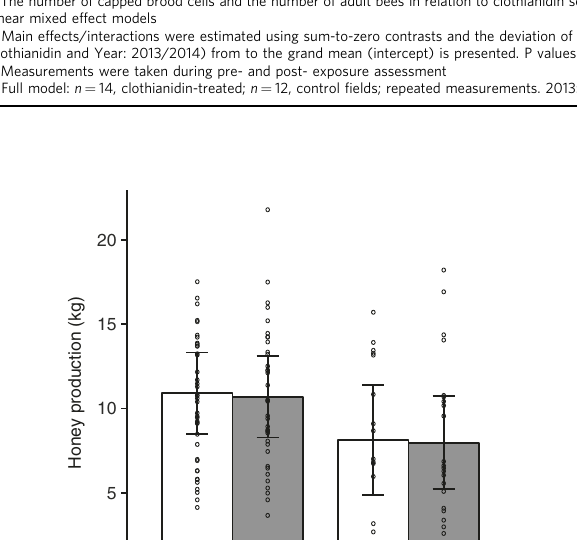
(Supplementary Table 1). Others (Big Sioux river virus (BSRV) and LSV-2) were effectively absent throughout the experiment, in all colonies, and were therefore similarly uninformative. Many viruses (acute bee paralysis virus (ABPV), chronic bee paralysis virus (CBPV), Israeli acute paralysis virus (IAPV), Kashmir bee virus (KBV) and slow bee paralysis virus (SBPV)) were largely